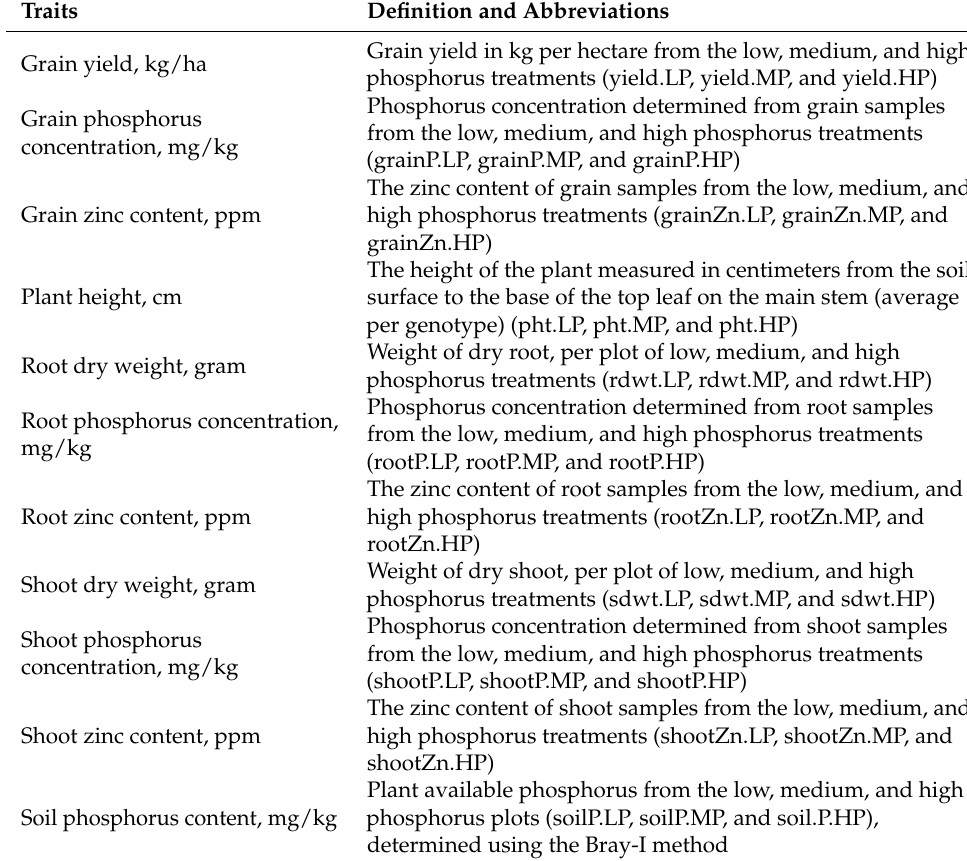
Table 1. List of trait names with their abbreviation and